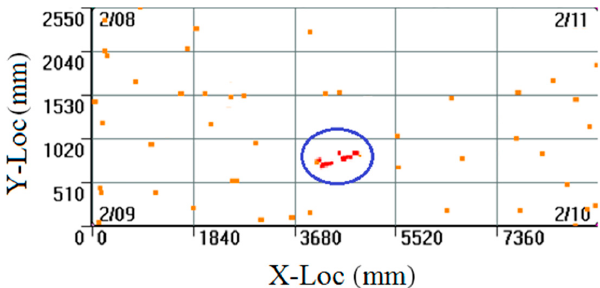
Figure 9. Planar location. Hsu-Nielsen source signals are marked by red, noise is marked by orange. Color of points indicates total number of events in this coordinates. Yellow points: 3–10 events, orange points: 11–25 events, red points: 26–100 events. Blue circle – location cluster of signals from Hsu-Nielsen source.